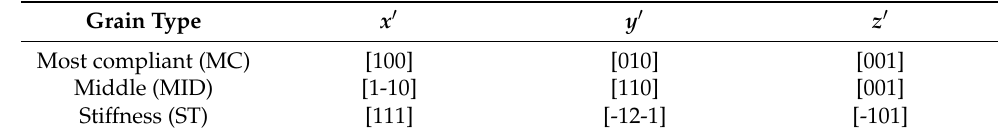
Table 1. Crystal orientations considered for grains.